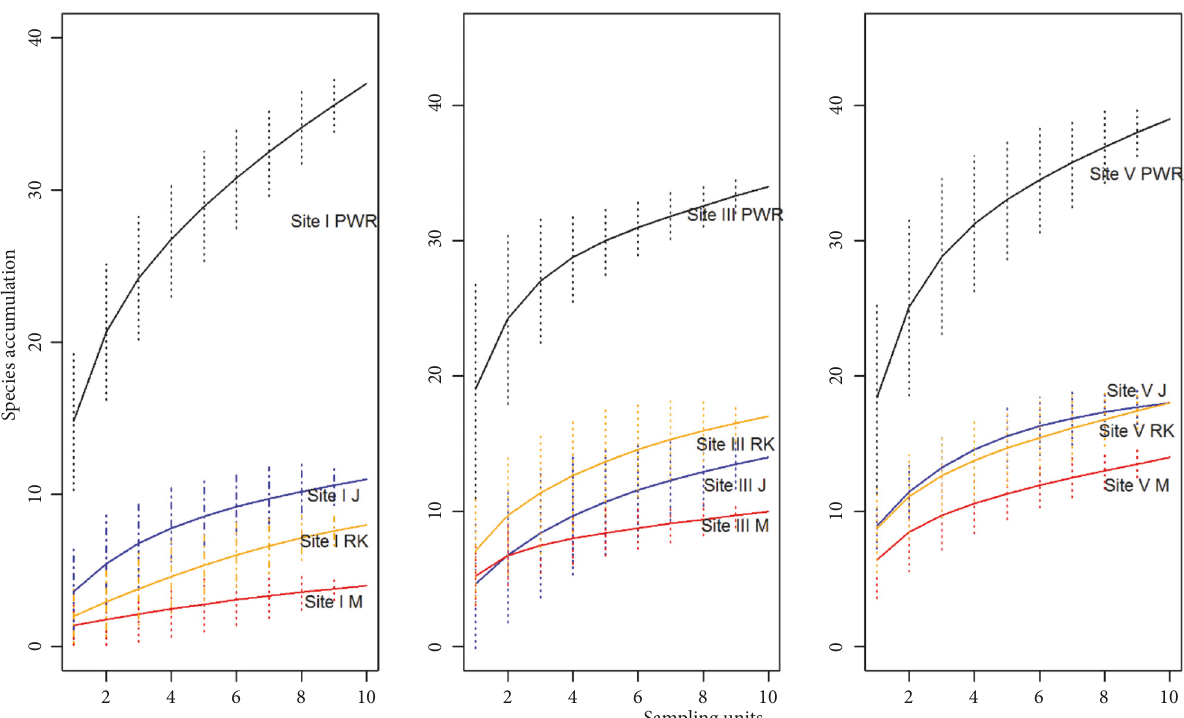
Figure 13: Species accumulation curves for different sites of studied forests plotted using Kindt’s exact method. The curves are for Sites I, Sites III, and Sites V for Janajagaran (J), Musharni Mai (M), Radha Krishna (RK), and Parsa Wildlife Reserve (PWR) forests. The species accumulationcurves reflected increase in number of species in the beginning with addition of sampling units. The vertical lines represent the standard